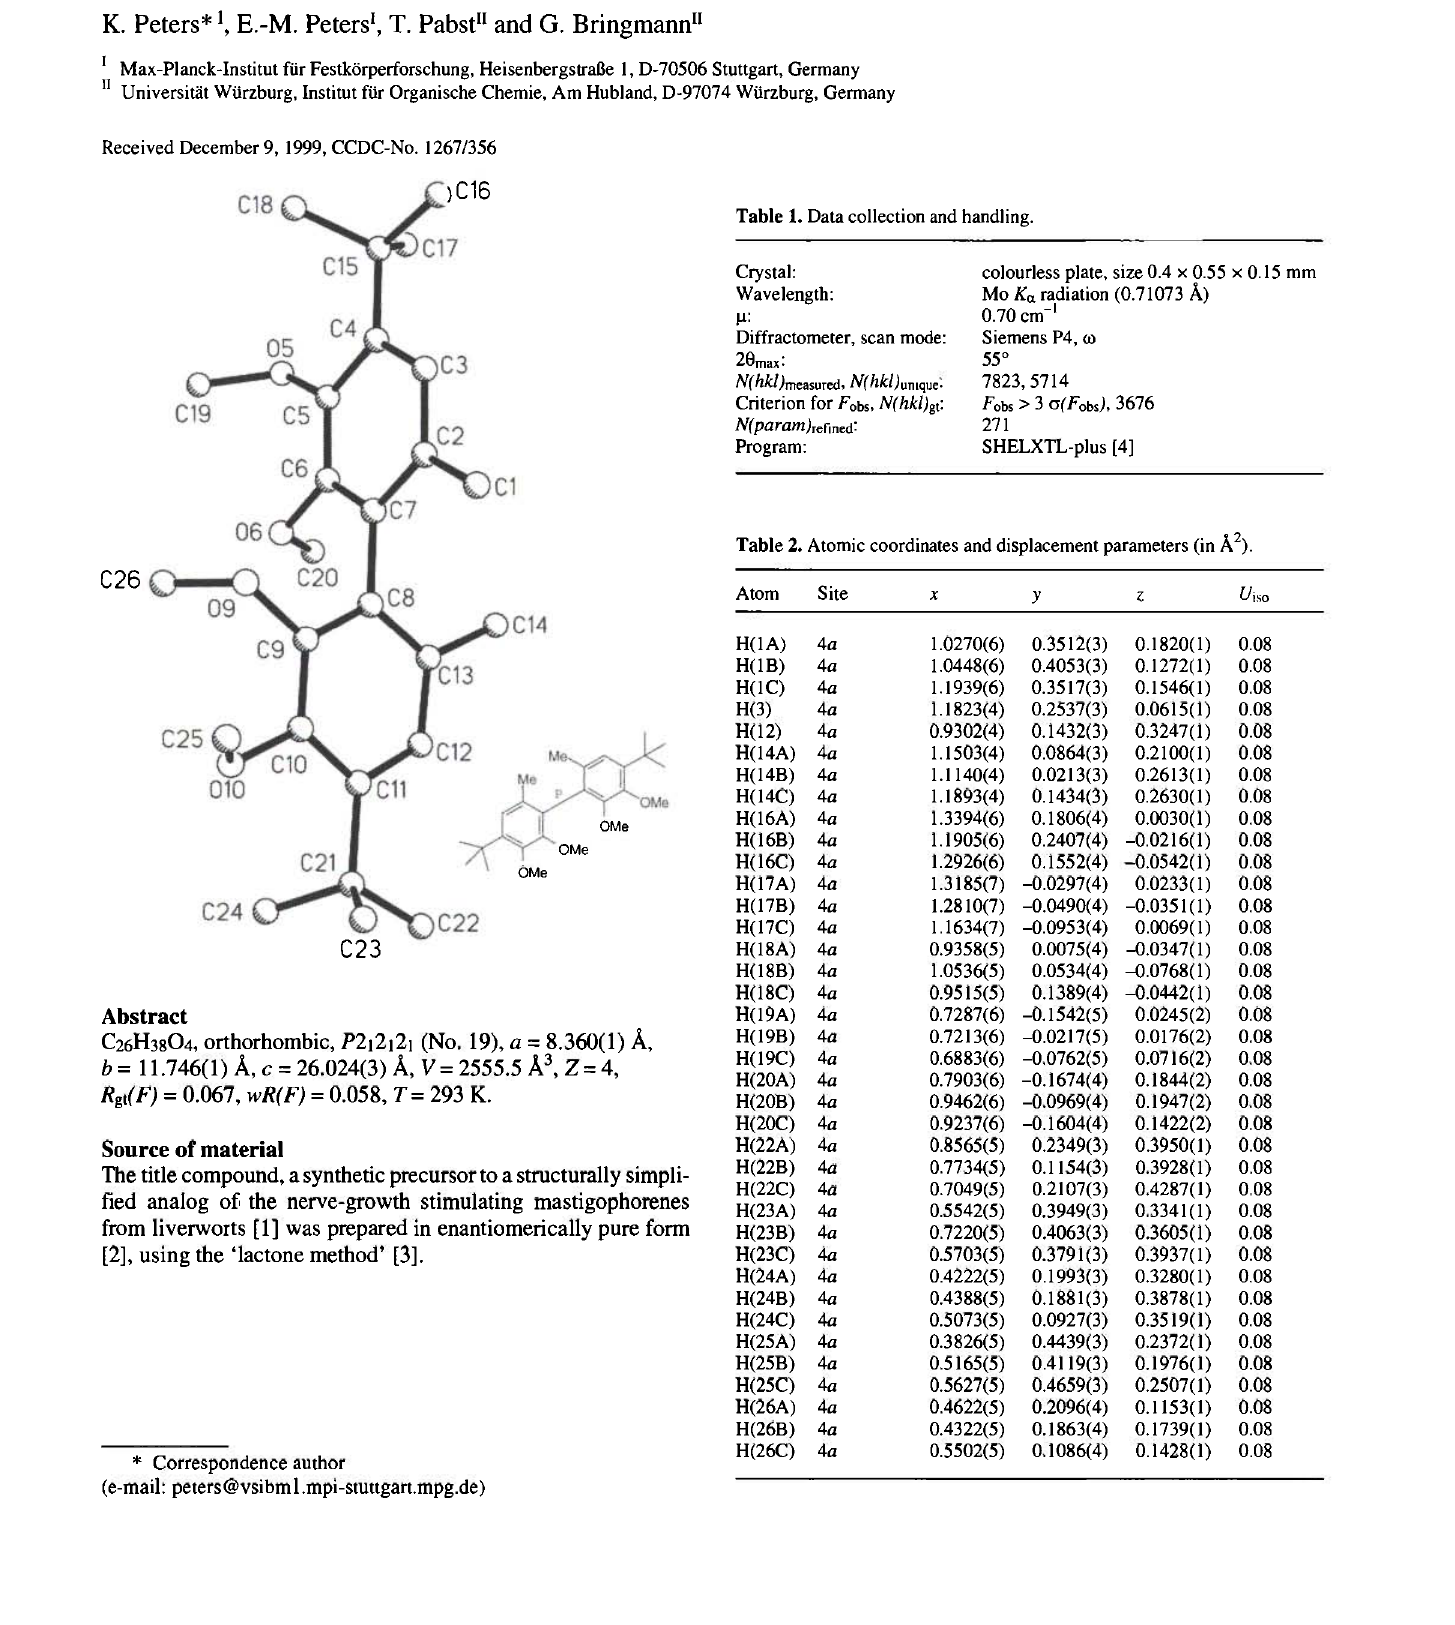
Table 2. Atomic coordinates and displacement parameters (in Ä 2